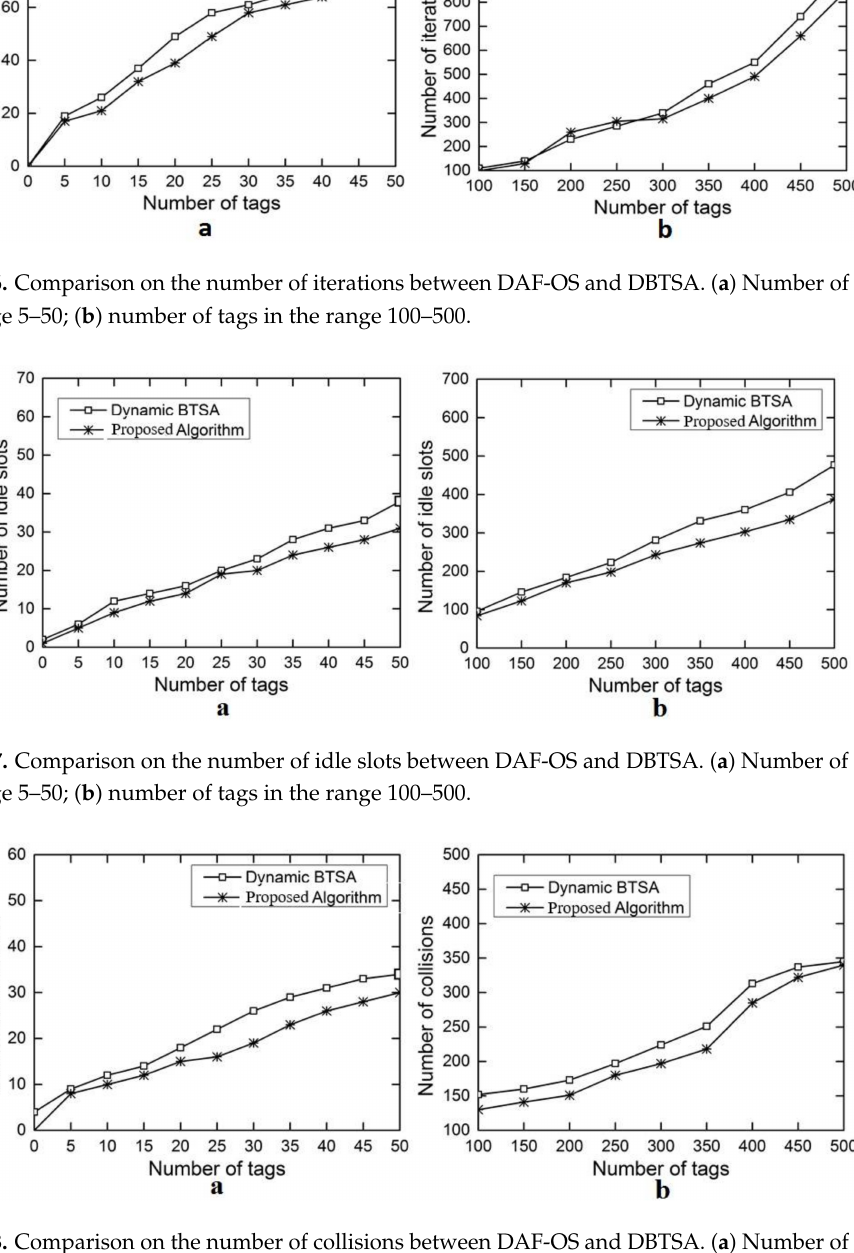
Figure 8. Comparison on the number of collisions between DAF-OS and DBTSA. ( a ) Number of tags in the range 5–50; ( b ) number of tags in the range